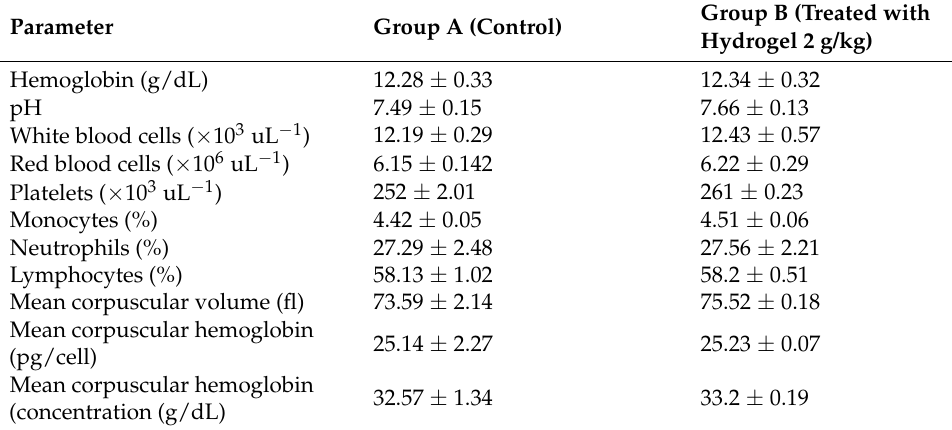
Table 4. Biochemical analysis of rabbits’ blood.